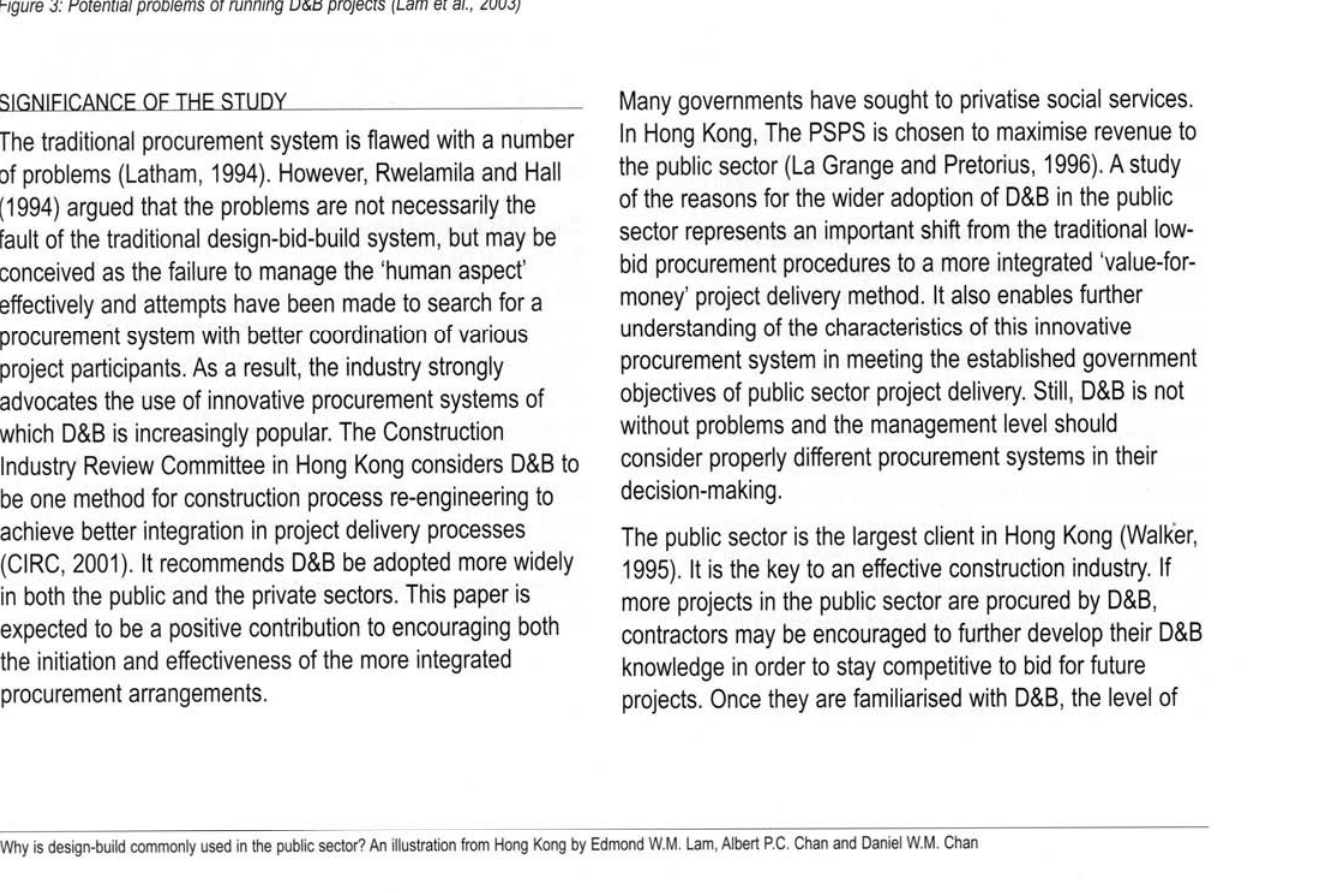
Figure 3: Potential problems of running D&B projects (Lam et al., 2003)